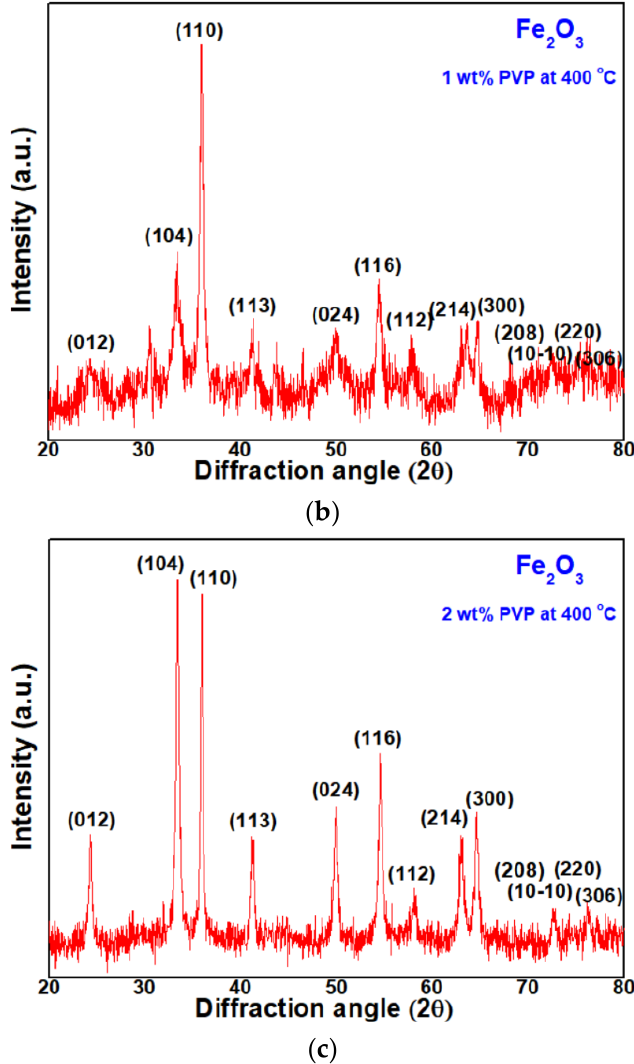
Figure 3. X-ray diffractometer (XRD) patterns of FeO x NPs with ( a ) 0 wt%; ( b ) 1 wt%; ( c ) 2 wt% polyvinylpolypyrrolidone (PVP).